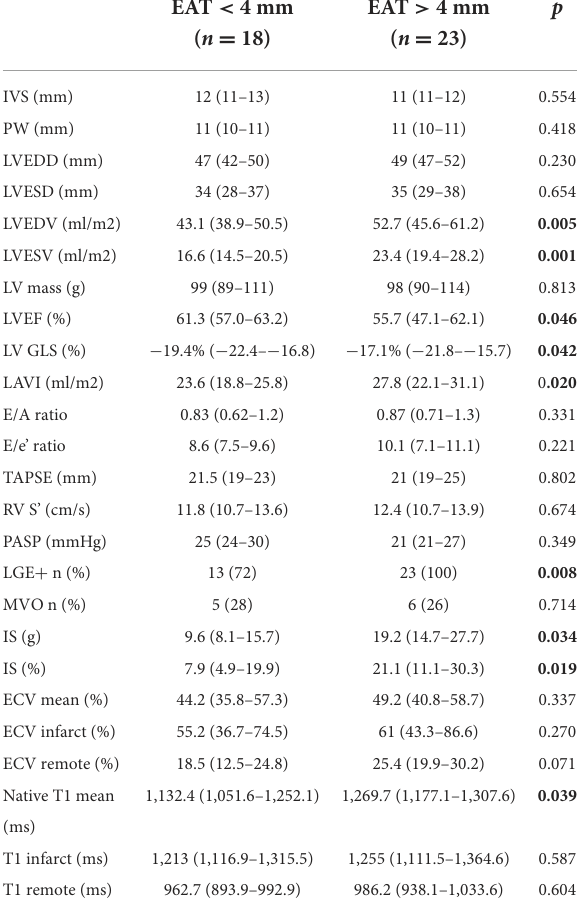
TABLE 2 TTE and CMR baseline